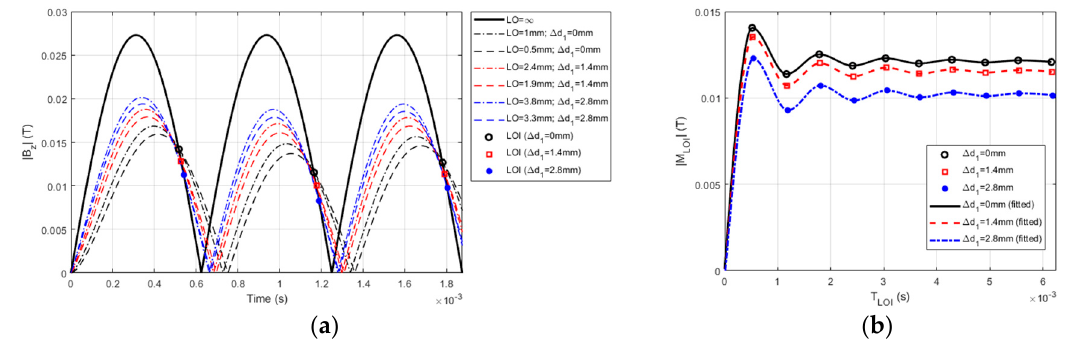
Figure 5. Characteristics of lift-off intersection (LOI) of PMEC signals: ( a ) PMEC signals and LOI points within the observation window (0 ms ≤ t ≤ 2 ms); ( b ) M LOI vs. T LOI against ∆ d 1.